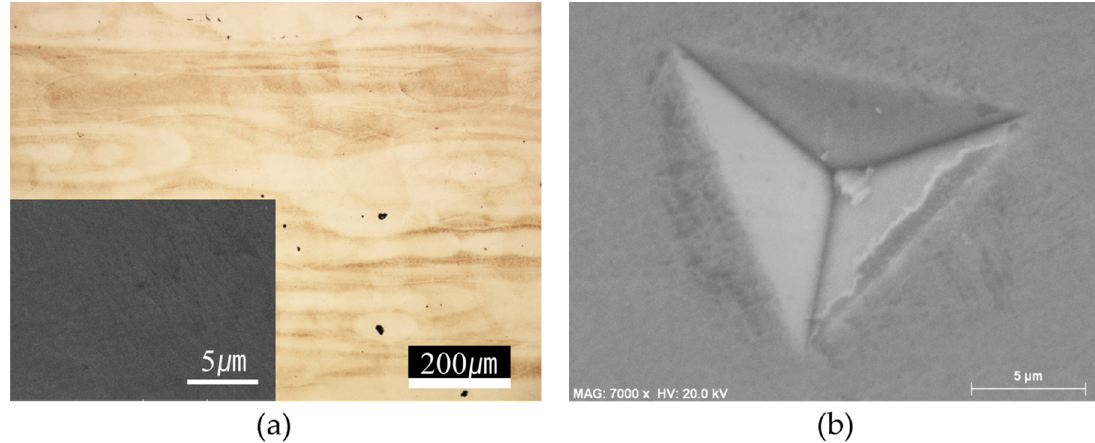
Figure 2. ( a ) Microstructure of the PBF- processed SKD61 at 800 mm/s scanning speed; ( b ) SEM graph of an indenter point after nanoindentation tests.